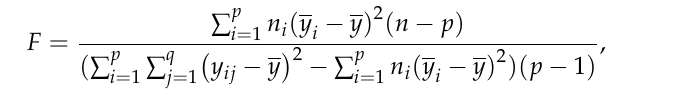
Table 7. The results of the analysis of the significance of the influence of the studied variables on Young’s modulus E . F F kr Result Conclusion Verification of the significance of the influence of sample thickness ( f 1 = 4, f 2 = 45) Ratio of tension direction Perpendicular to rolling direction Verification of the significance of the influence of rolling direction ( f 1 = 1, f 2 = 18)